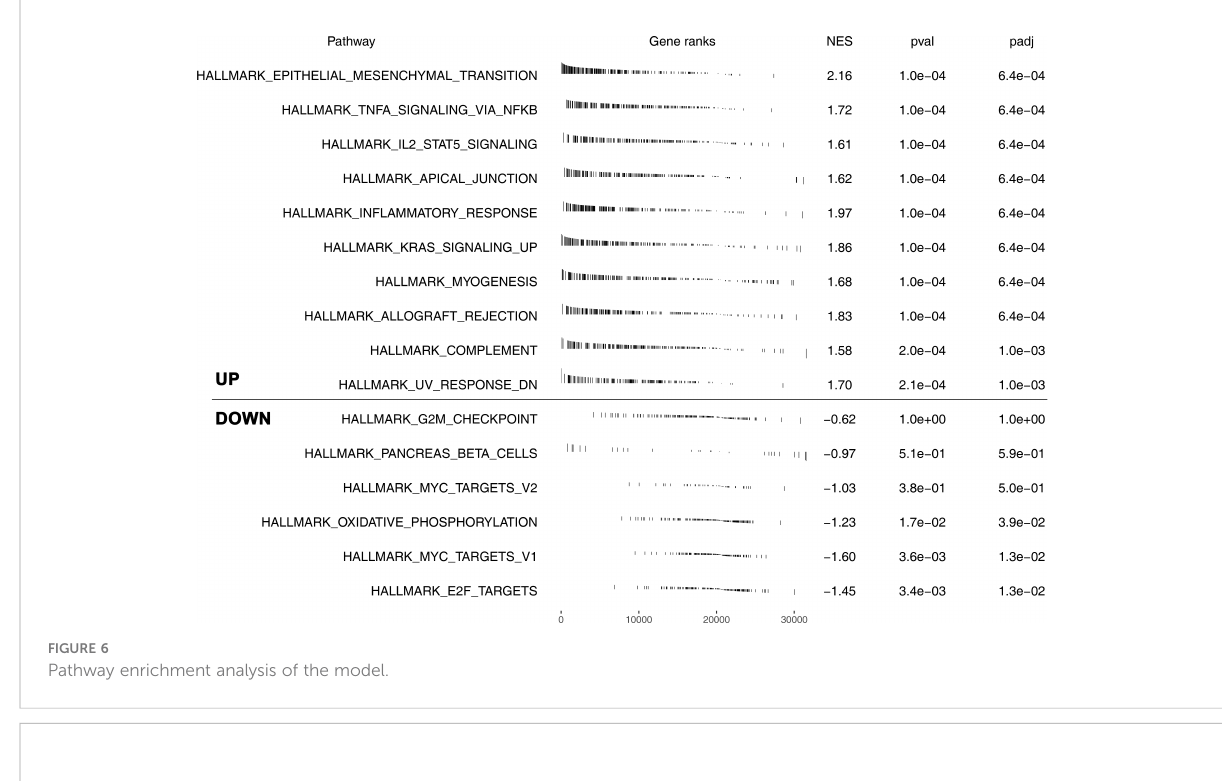
FIGURE 6 Pathway enrichment analysis of the model.